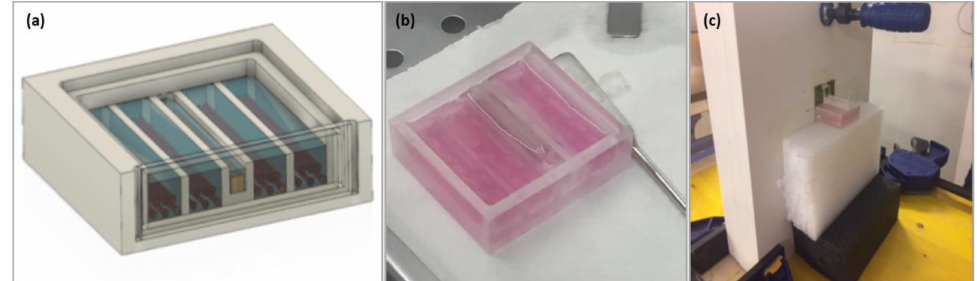
Figure 1. ( a ) Design of the bio-phantom implemented by the BioTech (UniTN) partner, containing both thermoluminescent dosimeters (TLDs-100) and cells. ( b ) Bio-phantom with an array of TLDs and cells included in the gelatine. ( c ) Bio-phantom ready for irradiation with the beam entering